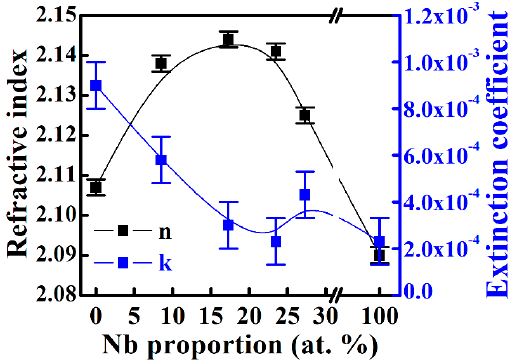
Figure 7. Refractive index at 550 nm and extinction coefficient at 450 nm for different niobium proportions.